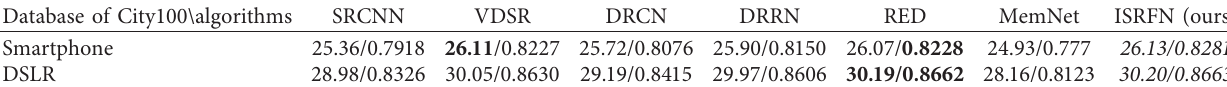
Table 1: The performances (PSNR/SSIM) of the selected state-of-the-art